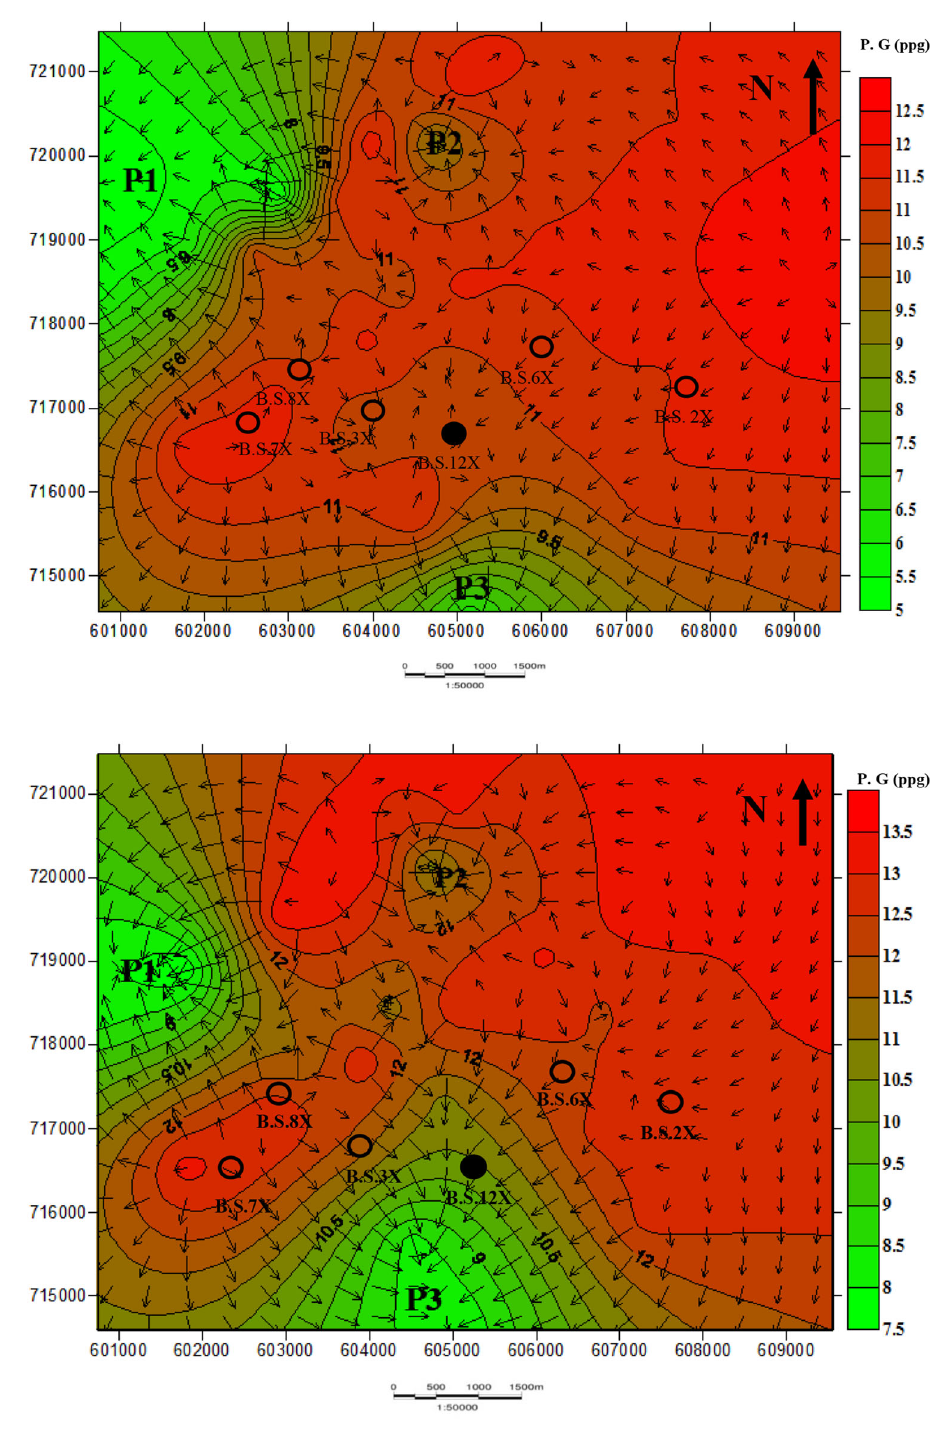
Fig. 16 Pore pressure